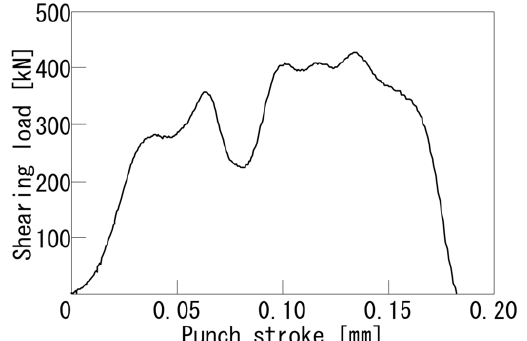
Figure 10. Shearing load – punch stroke curve at 980 MPa.